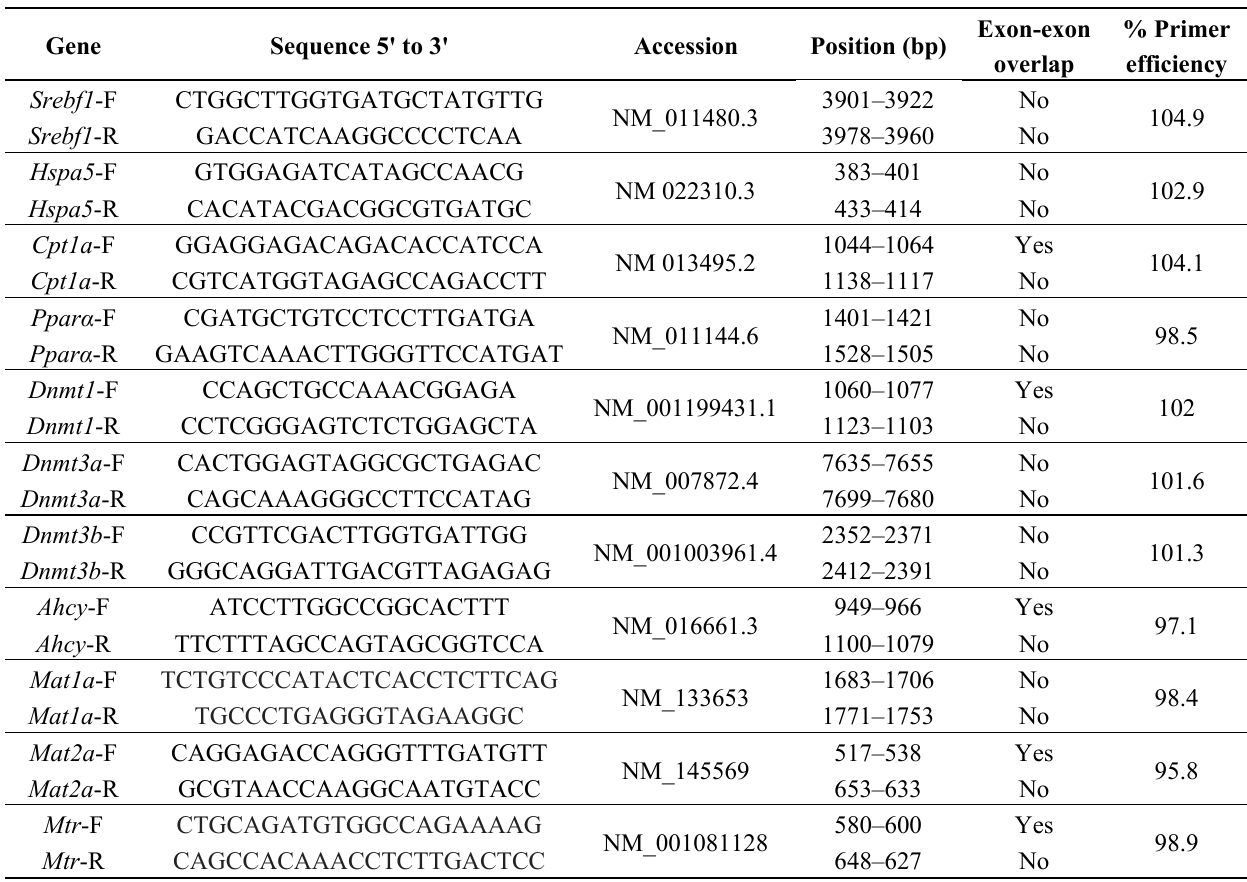
Table 2. qPCR primer sequences of selected